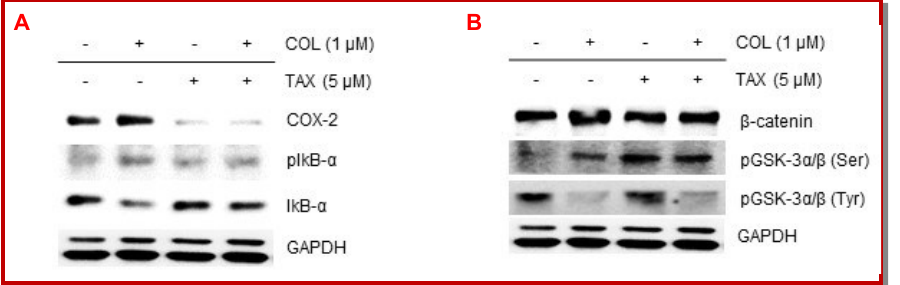
Figure 6: Colchicine causes inflammation via NF- κ B pathway in articular chondrocytes Chondrocytes were either left untreated or given 20 μ M BMS for 3 hours before being subjected to 1 μ M colchicine for 24 hours (Figure A). Western blot analysis was used to find the expression of COX-2, pI κ B α, I κ B α and GAPDH. GAPDH was used as a loading control. (B) Chondrocytes were subjected to 1 mM colchicine for 24 hours after being left untreated or treated for 3 hours with 5 mM TAX. Western blot analysis was used to find the expression of COX-2, pI κ B α, I κ B α , and